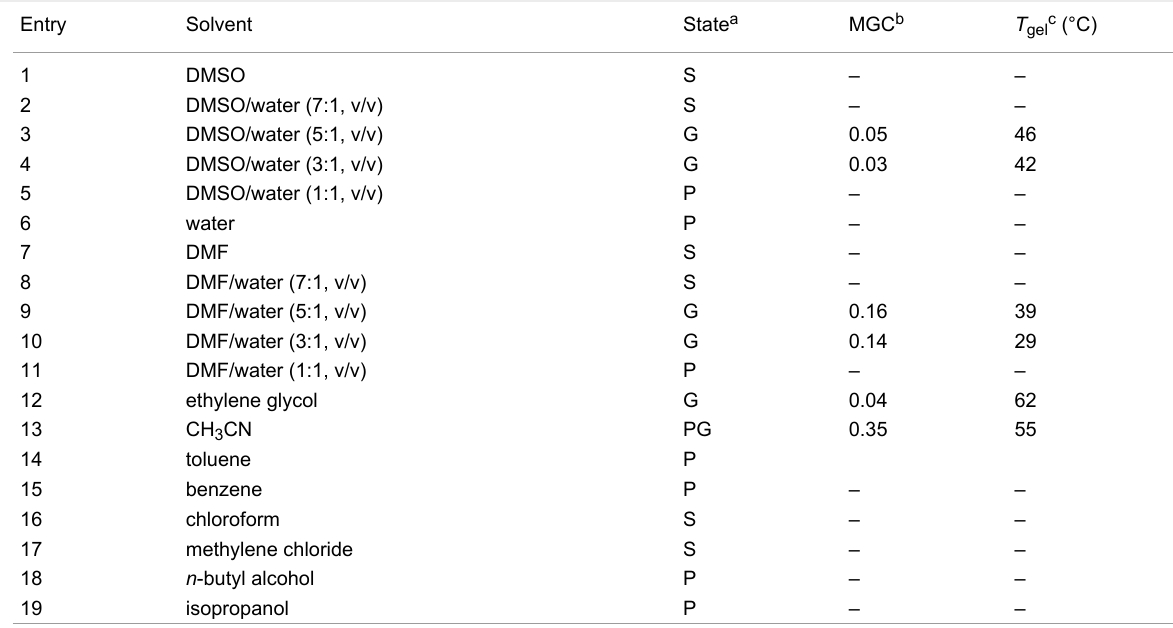
Table 1: Gelation test results of GA-pyrene ( 3 ) with TNF ( 4 , molar ratio =1:1).